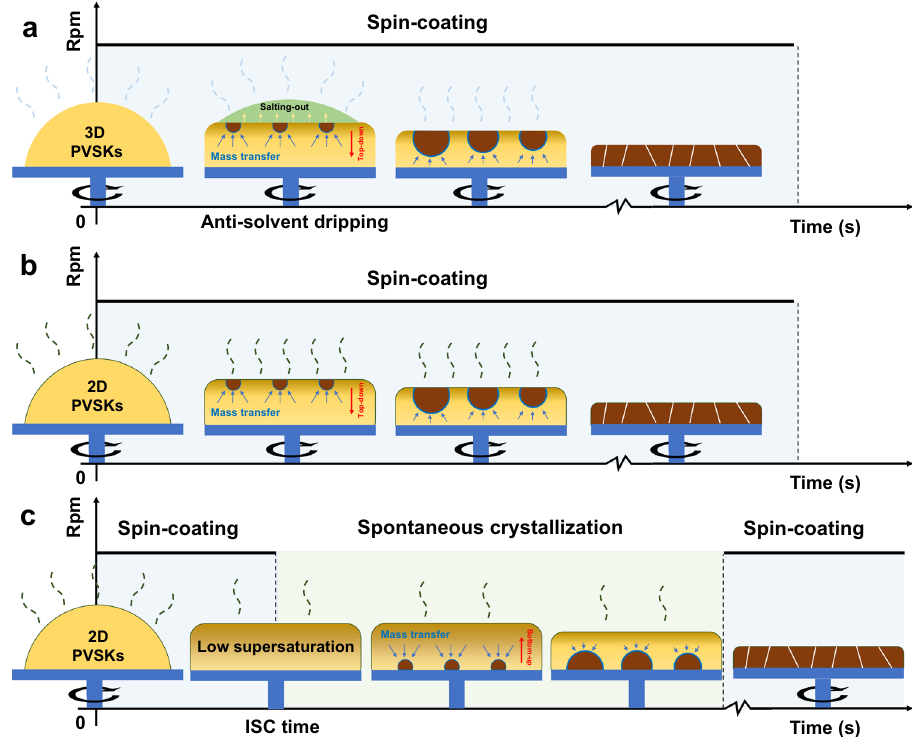
Fig. 1 Illustrative of top-down and bottom-up crystallization. Conventional downward crystallization by a anti-solvent dripping in 3D PVSKs, b direct spin- coating in 2D PVSKs and c upward crystallization by ISC method in 2D